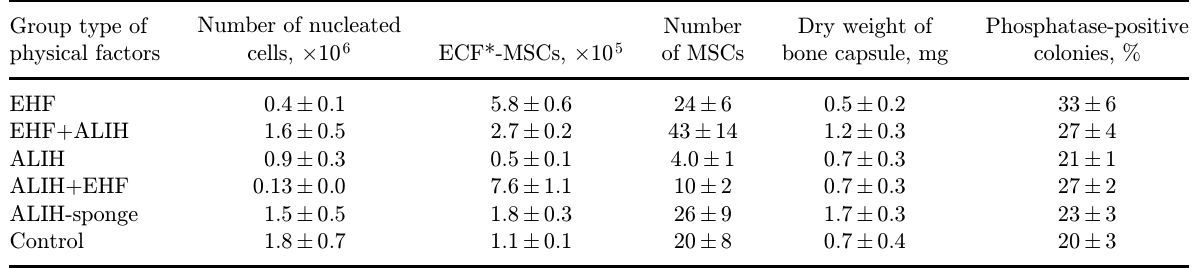
Table 1. Cell number, ECF-MSCs, weight of bone capsules, and phosphatase-positive colonies in three months transplants of bone marrow in mice ( M (cid:3) m ). Group type